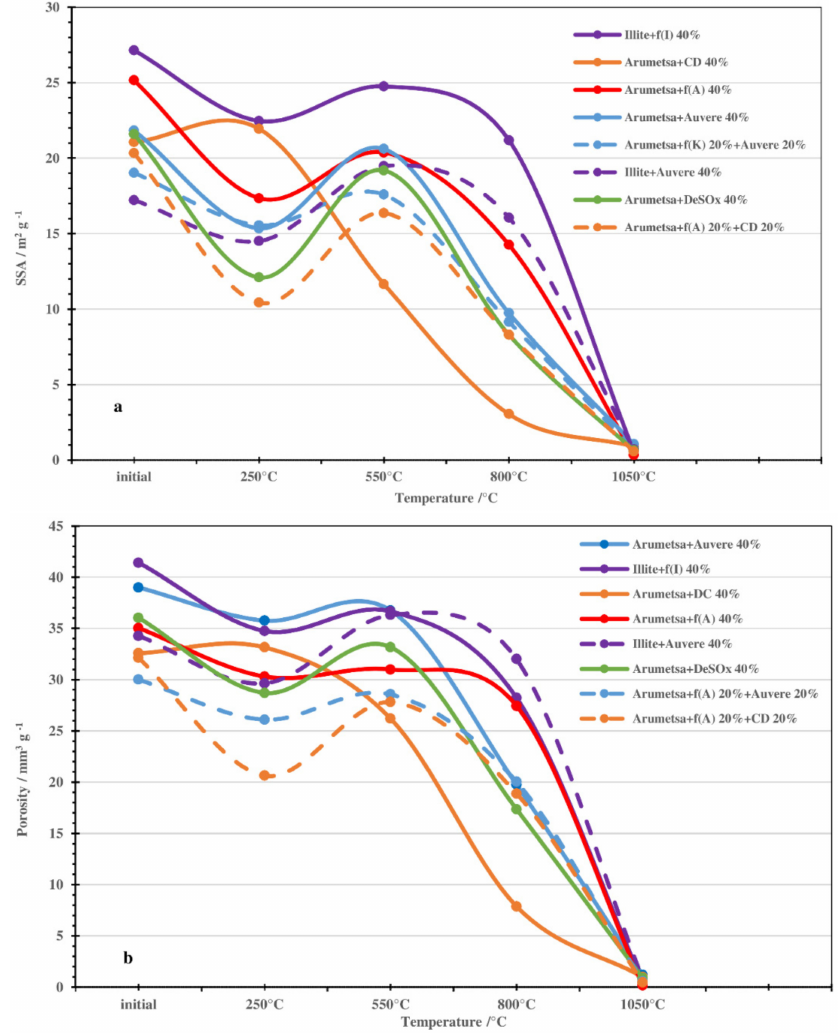
Figure 5. Changes in SSA ( a ) and porosity ( b ) values of initial and thermally treated blends with different additives. The particle surfaces of the Arumetsa (SSA: 0.34 m 2 g − 1 ; porosity: 0.18 mm 3 g − 1 ) (Figure 6a) and illitic clay (SSA: 0.59 m 2 g − 1 ; porosity: 0.47 mm 3 g − 1 ) (Figure 6e) treated thermally at 1050 ◦ C were almost completely covered with a glassy phase. Auvere FA, DeSOx and clinker dust additives improved the structures of the samples treated at 1050 ◦ C by increasing the melting points of the blends, with a following increase in the porosity and SSA values of the samples and a decrease in the melting points on the surfaces of the particles. For example, for the blend of Arumetsa clay with 40% Auvere FA (Figure 6b), the SSA and V pores values were 1.06 m 2 g − 1 and 1.18 mm 3 g − 1 (these values for illitic clay with 40% Auvere FA were 1.02 m 2 g − 1 and 1.20 mm 3 g − 1 , respectively (Figure 6f)), while those with 40% DeSOx were 0.65 m 2 g − 1 and 0.90 mm 3 g − 1 (Figure 6c) and those with 40% clinker dust were 0.90 m 2 g − 1 and 0.99 mm 3 g − 1 (Figure 6d),